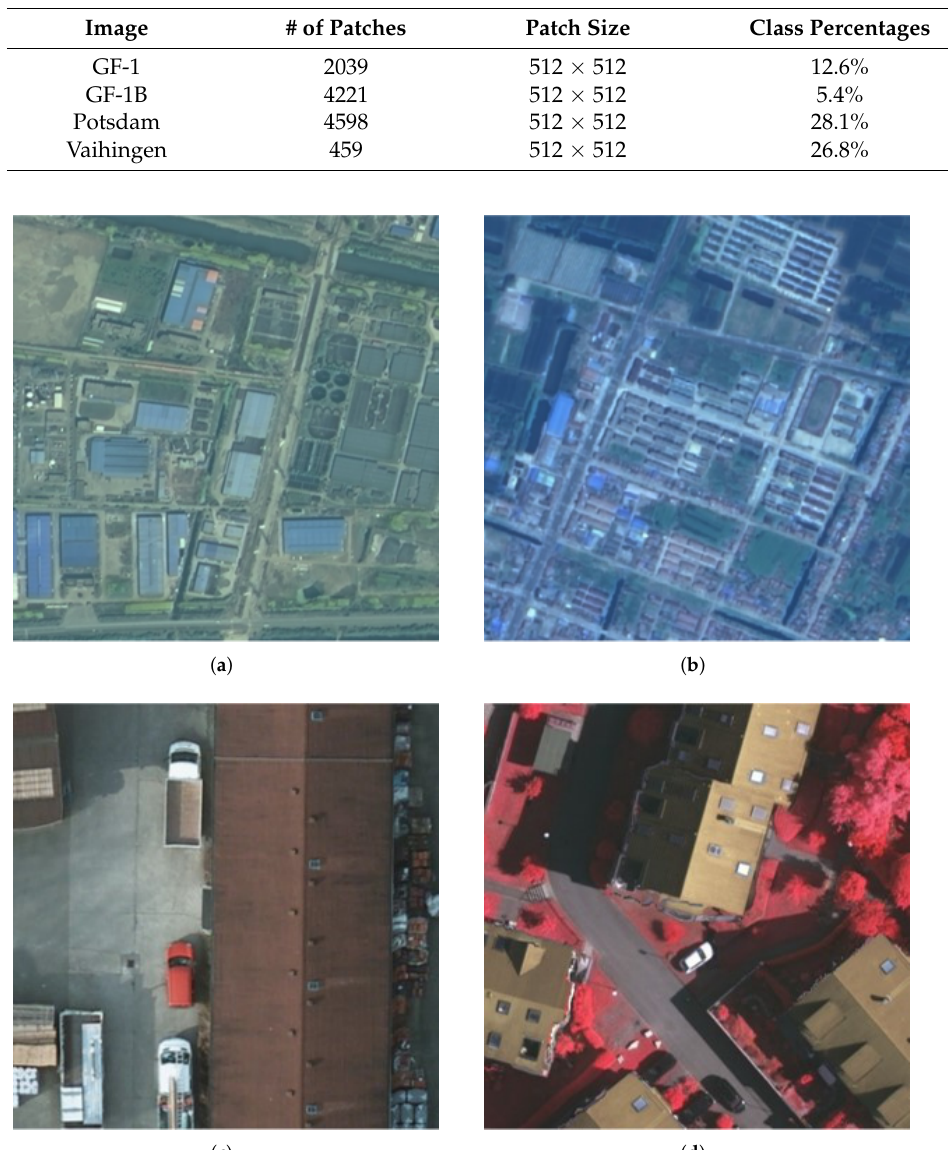
Figure 7. Example patches from two datasets. ( a ) GF-1 satellite image of the Gaofen dataset. ( b ) GF-1B satellite image of the Gaofen dataset. ( c ) Potsdam image of ISPRS dataset. ( d ) Vaihingen image of the ISPRS